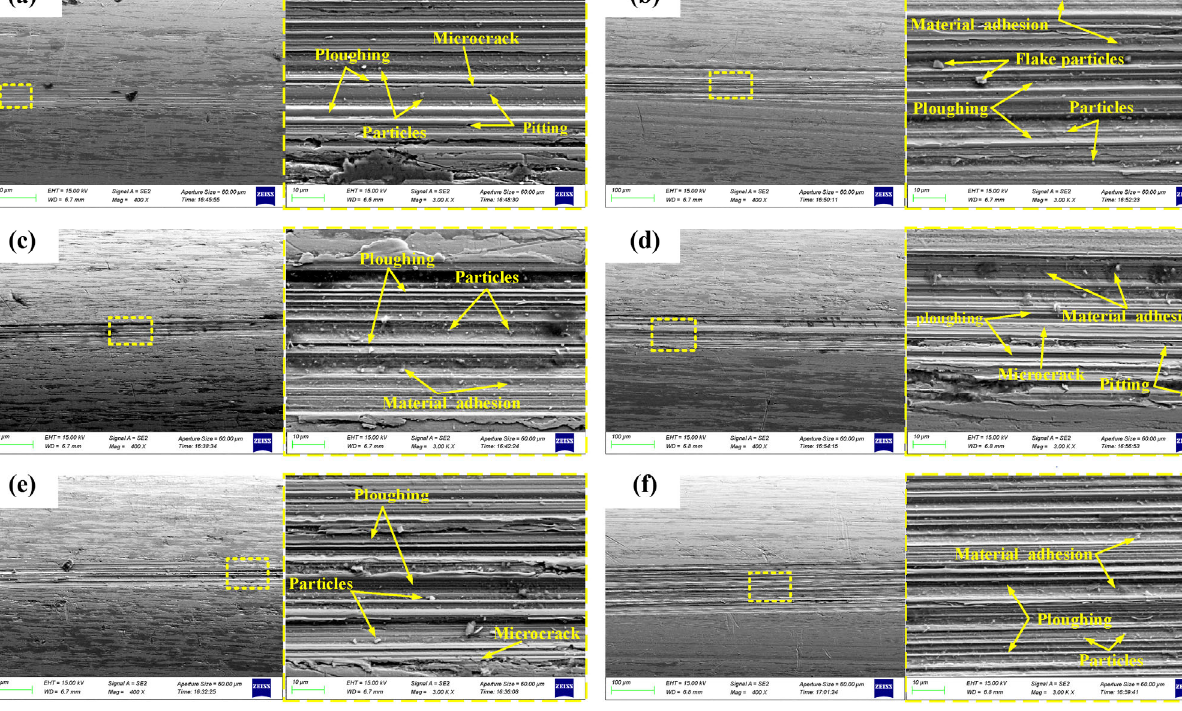
Fig. 23 Wear morphologies of different lateral loads and twist angles under oil lubrication. (a) 4.2° + 80 N, (b) 4.2° + 160 N, (c) 5.4° + 80 N, (d) 5.4° + 160 N, (e) 6.6° + 80 N, and (f) 6.6° + 160